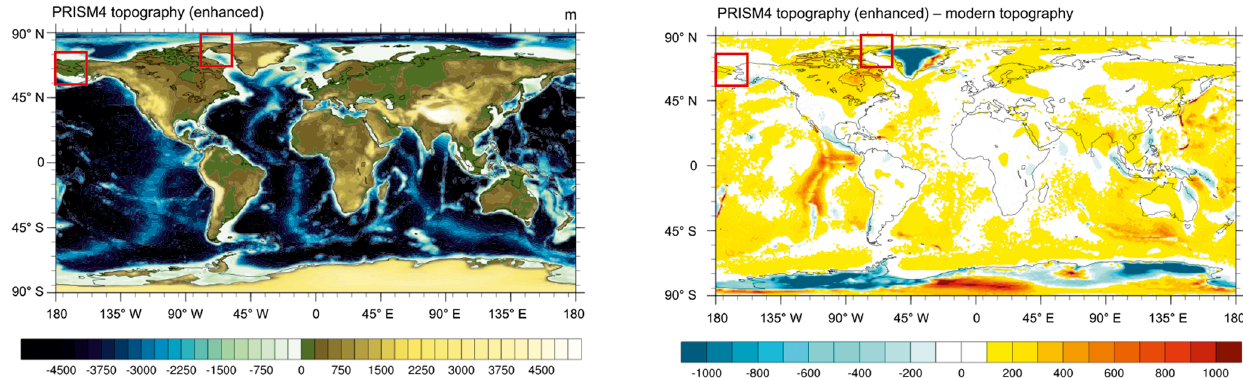
Figure 3. PRISM4 palaeogeography (enhanced) including topography/bathymetry (m) over the ice sheets (left). PRISM4 topographic and bathymetric anomaly (m) from modern (ETOPO1: right). Red boxes highlight the Canadian archipelago and Bering Strait as closed in both the standard and enhanced boundary condition data